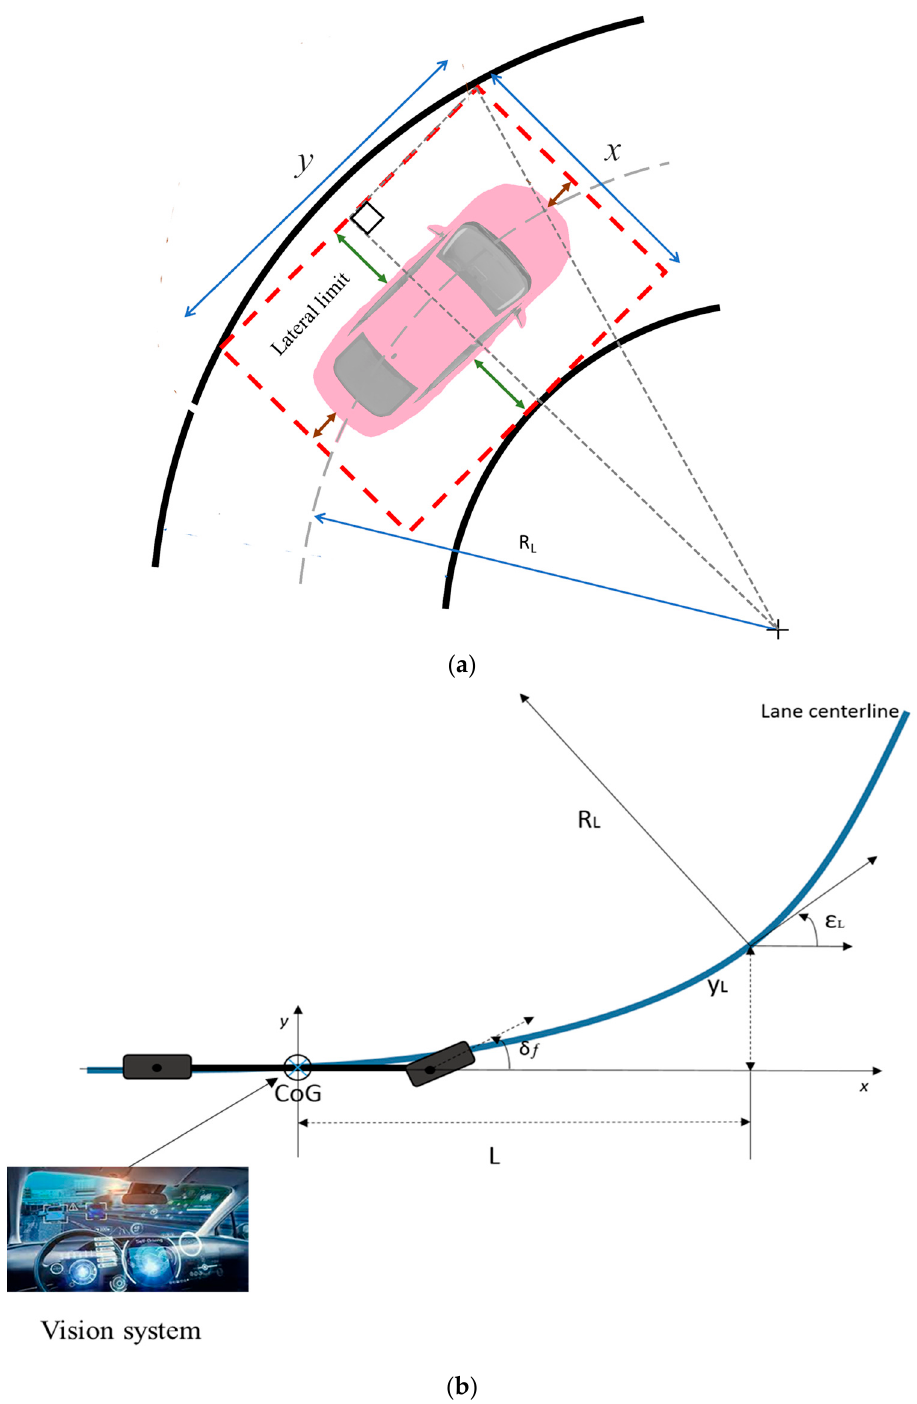
Figure 2. The vision dynamics graphical representation ( a ) 3-D schematic, ( b ) single line